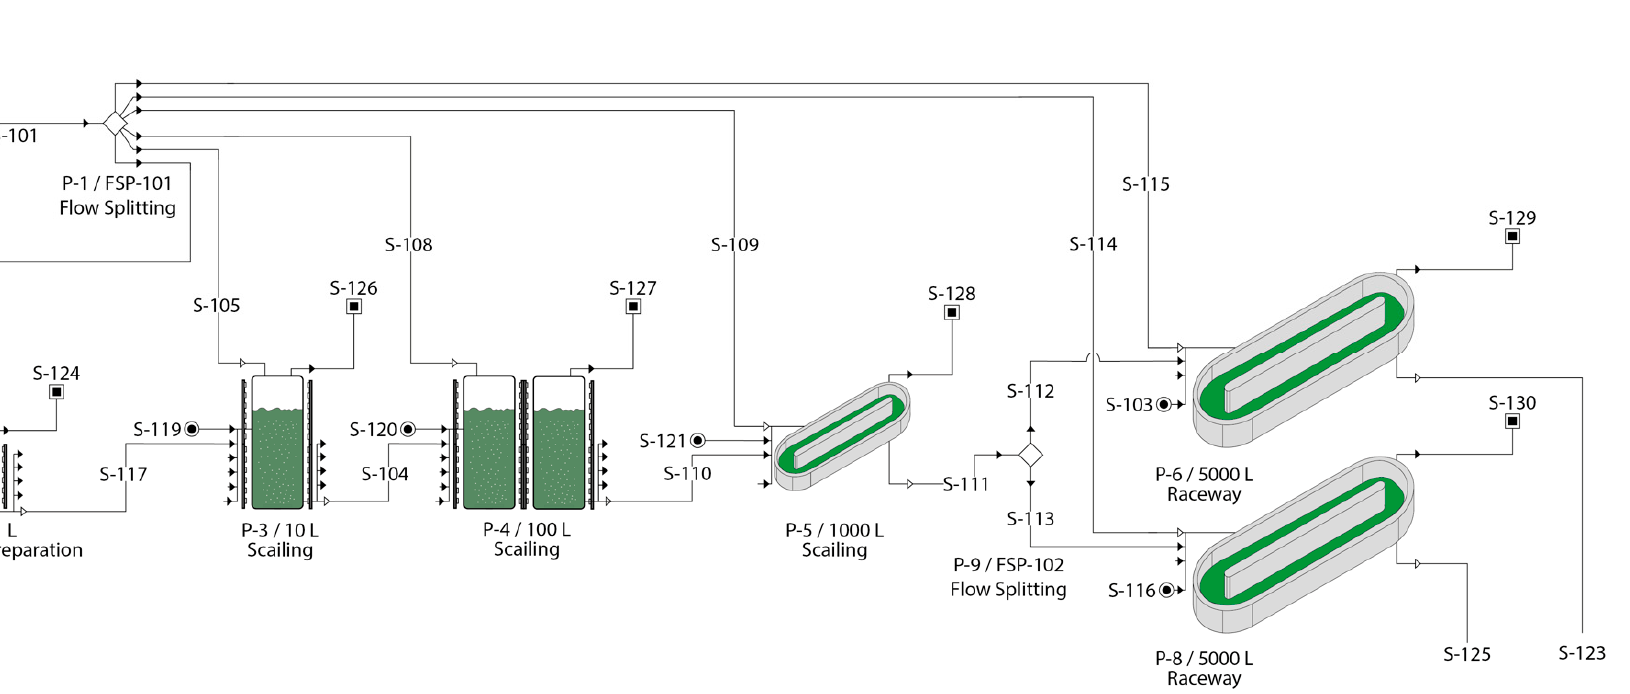
Figure 4. Flow diagram of the upstream-process production of Chlorella sp.